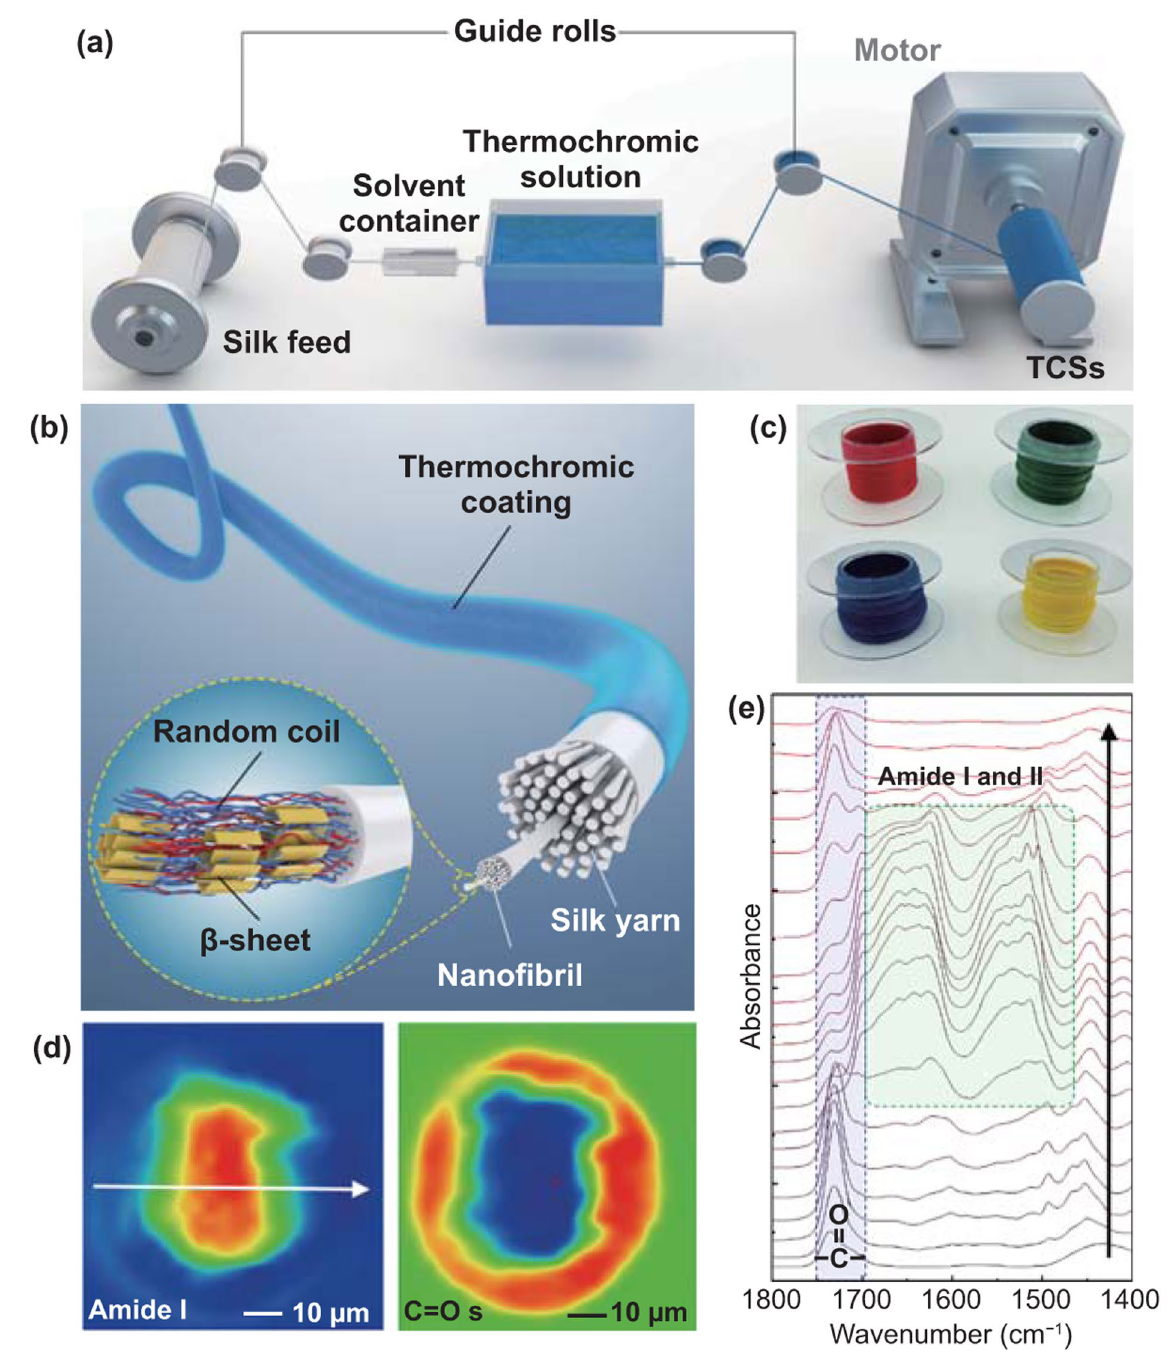
Fig. 2 Spinning, structures, and properties of TCSs. a Schematic diagram of the continuous spinning device to produce TCSs. b Schematic illustration of the hierarchical interfaces in TCS fibers. c Photographs of red, green, blue and yellow TCS fibers. d S-FTIR spectroscopic images of TCS slice by integrating the characteristic peak of the silk at 1656 cm −1 (amide I) and the peak of inks at 1729 cm −1 (C=O stretching). e The single-pixel spectras extracted along the direction indicated by the white arrow in